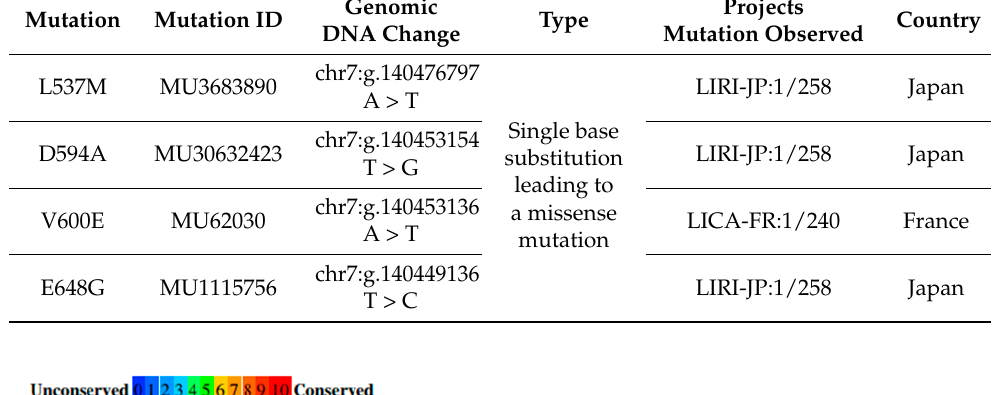
Table 1. BRAF mutations were identified by ICGC and subjected to functional analysis.